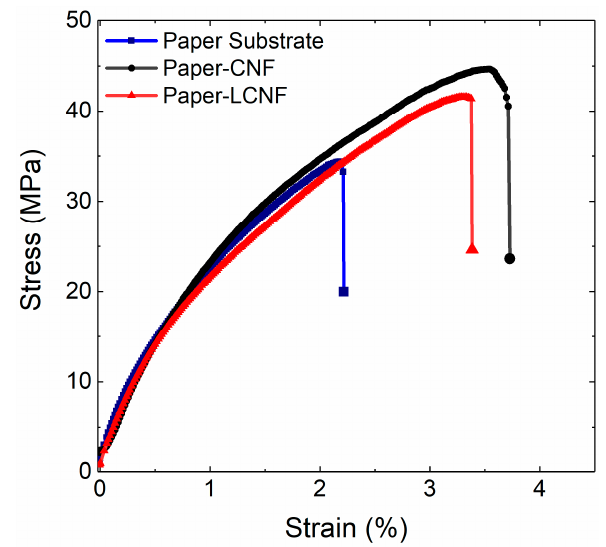
Figure 6. Representative stress-strain curves of the paper substrates before/after coating with CNF and LCNF . Table 1. Films’ tensile properties (tensile strength and tensile strain) obtained from the stress-strain curves.